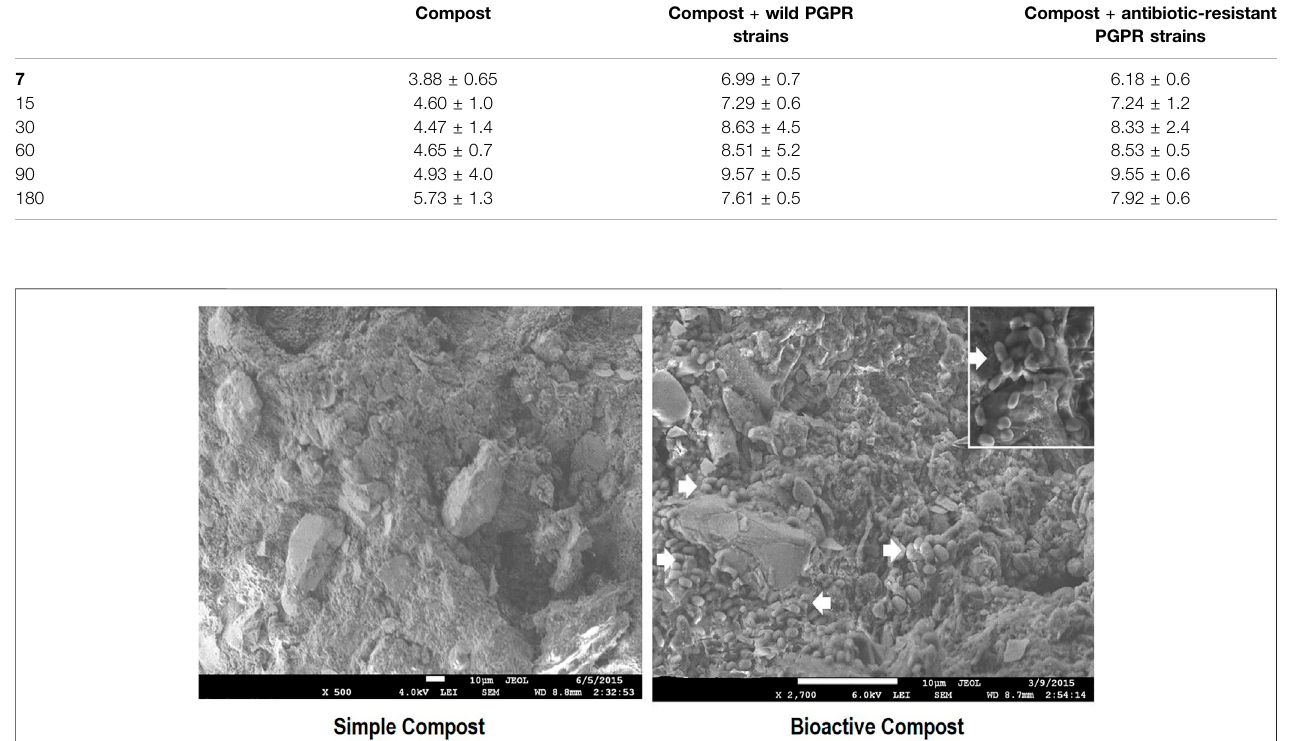
FIGURE2| Fieldemissionscanningelectronmicroscopic(FESEM)analysisofinoculatedcompostat90 dpitovisualizePGPRcompositionandcompoststructure compared to non-inoculated.